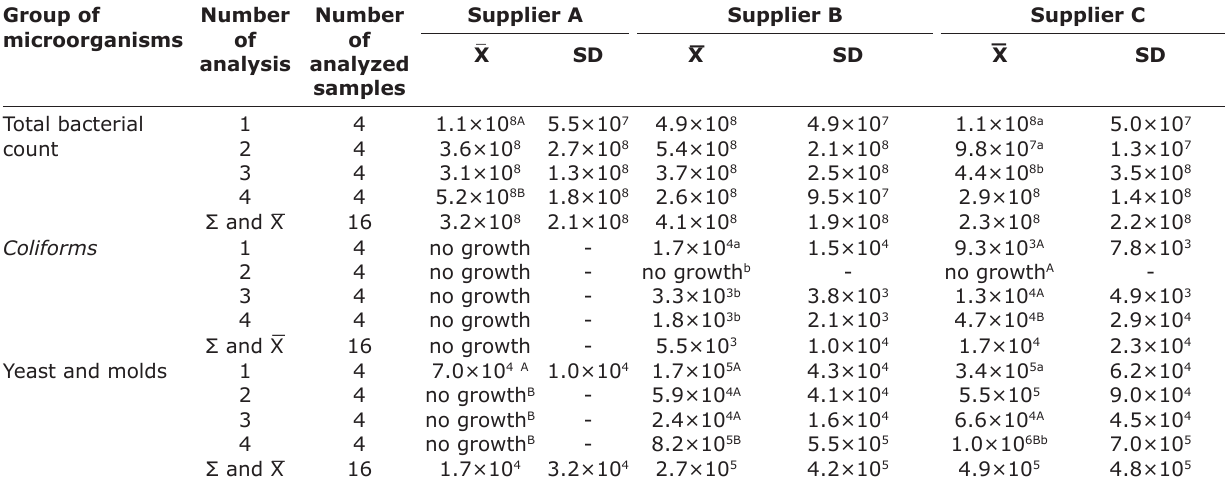
Table-3: Changes in the numbers of microorganisms in the curd cheese samples from each supplier in consecutive studies. Group of Number microorganisms